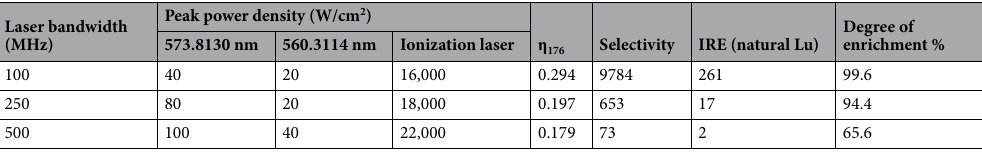
Table 3. Variation in the selectivity, isotope ratio enhancement (IRE) factor and degree of enrichment of 176 Lu (for the Doppler free case) with the increase in the laser bandwidth.